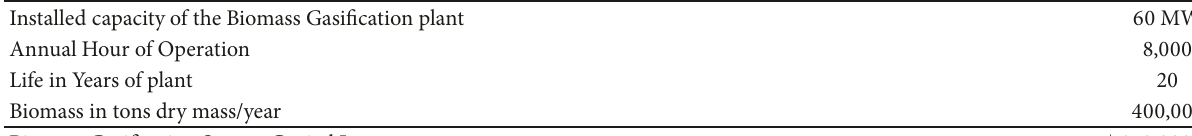
Table 17: Estimated cost structure of biomass gasification plant.